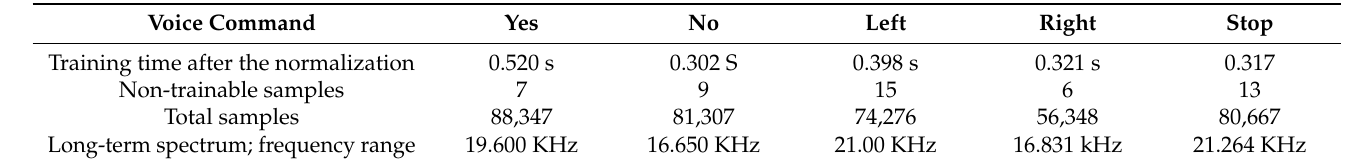
Table 4. Resizing and normalization phases for the voice commands.